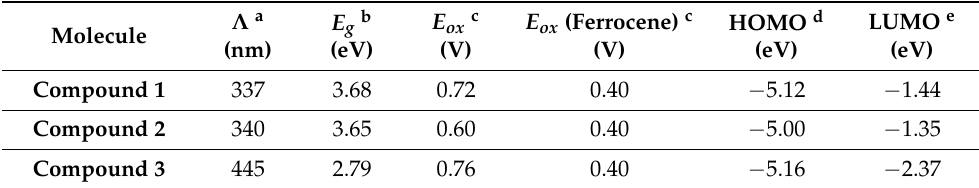
Table 1. Summary of energy levels and E g of Compounds 1 – 3 .